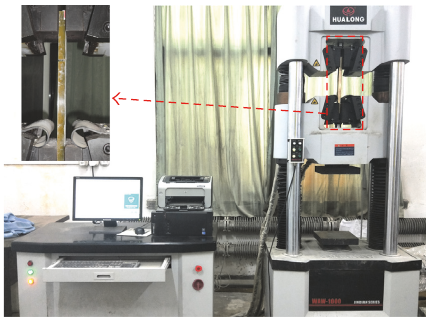
Figure 3: The tensile test machine